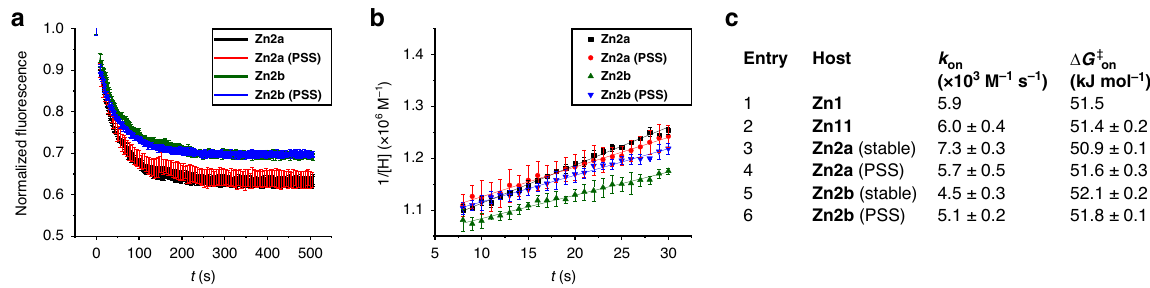
Fig. 6 Threading experiments. a Normalized fl uorescence intensity of the host measured as a function of time, after the addition of 1.0 equivalent of V15 ([host] 0 = [ V15 ] 0 = 10 − 6 M in CHCl 3 /CH 3 CN, 1:1, v/v). b Second-order kinetics plots for the complexation of hosts Zn2a and Zn2b , and their PSS mixtures with V15 for the initial stages (~ fi rst 50%) of the threading process. c Kinetic and thermodynamic data for the threading of porphyrin